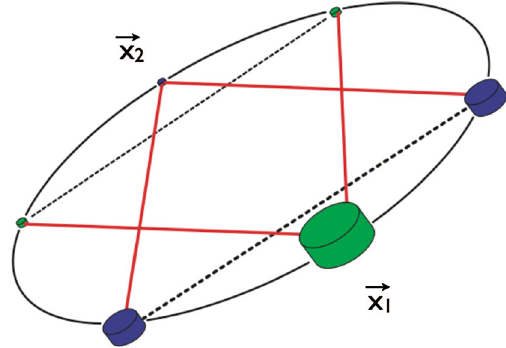
Fig. 35 Hexagram configuration for the cross-correlation of two LISA-like detectors, relevant for the proposed Big-Bang Observer space mission. Spacecraft, which house lasers and freely-falling test masses, are located at each vertex of the hexagram. The vectors (cid:5) x 1 and (cid:5) x 2 denote the vertices of two equal-arm Michelson interferometers, with opening angle β = 60 ◦ . Image reproduced with permission from Cornish and Larson (2001), copyright by IOP